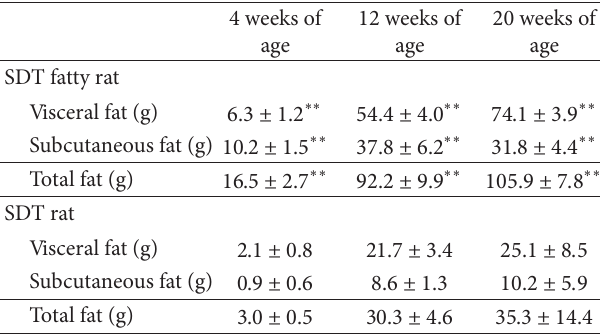
T 1: Changes of fat tissue weights in SDT fatty rats and SDT rats. Visceral and subcutaneous fat tissue weights were